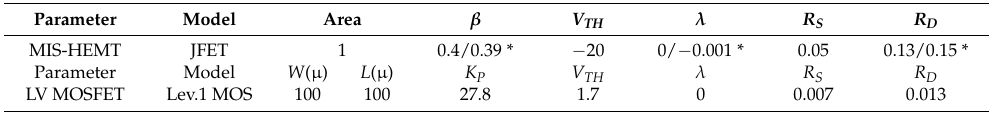
Table 1. Parameters of the junction field-effect transistor (JFET) and level-1 metal–oxide–semiconductor field-effect transistor (MOSFET) models in the fabricated GaN FET.